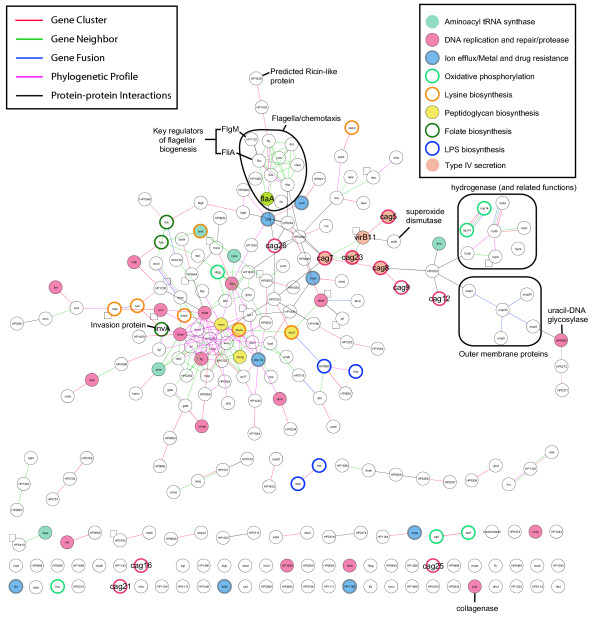
Annotated prolinks network view of 263 genes identified to beputatively functionally associated with one or more of the 26 cytotoxin-associated cag genes in H. pylori. This filtered network was obtained through selection of genes in biclusters of putatively co-regulated containing one or more cag gene(s). The cag genes are indicated with pink node borders. See inset keys for description of node and edge coloring.